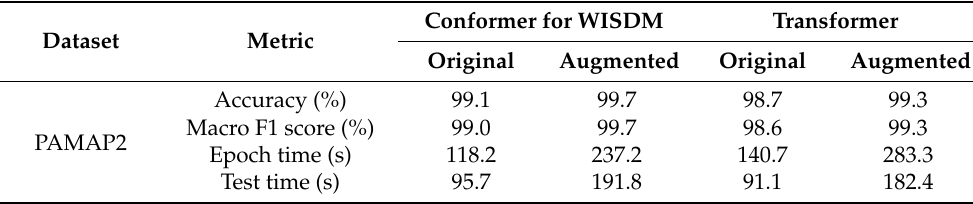
Table 5. Performance of proposed model before and after data augmentation in PAMAP2. Dataset